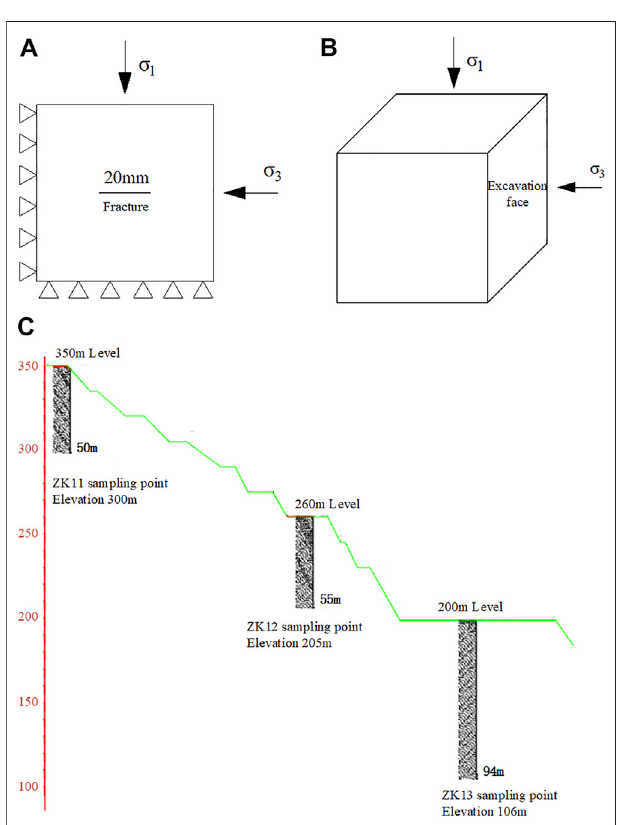
FIGURE 3 | Model diagram. (A) Model geometry; (B) force diagram; (C) layout of sampling points in the fractured rock